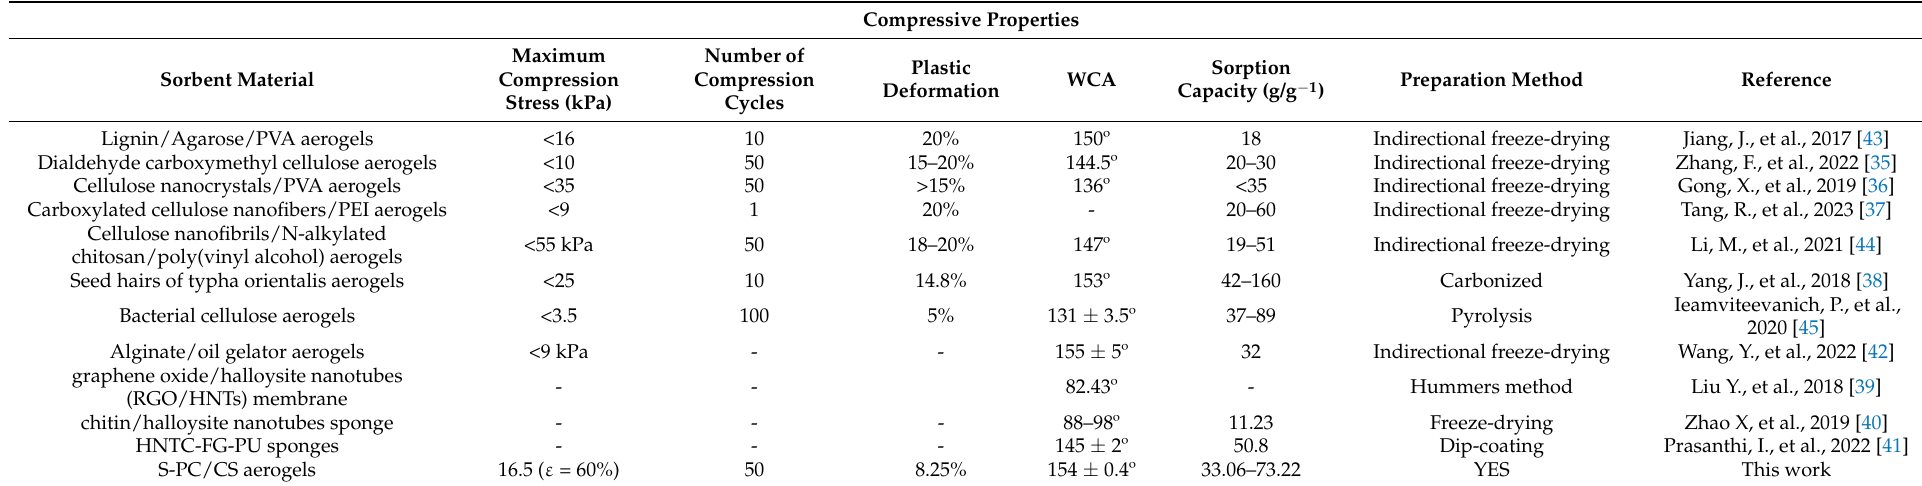
Table 1. Comparison of properties of different sorption